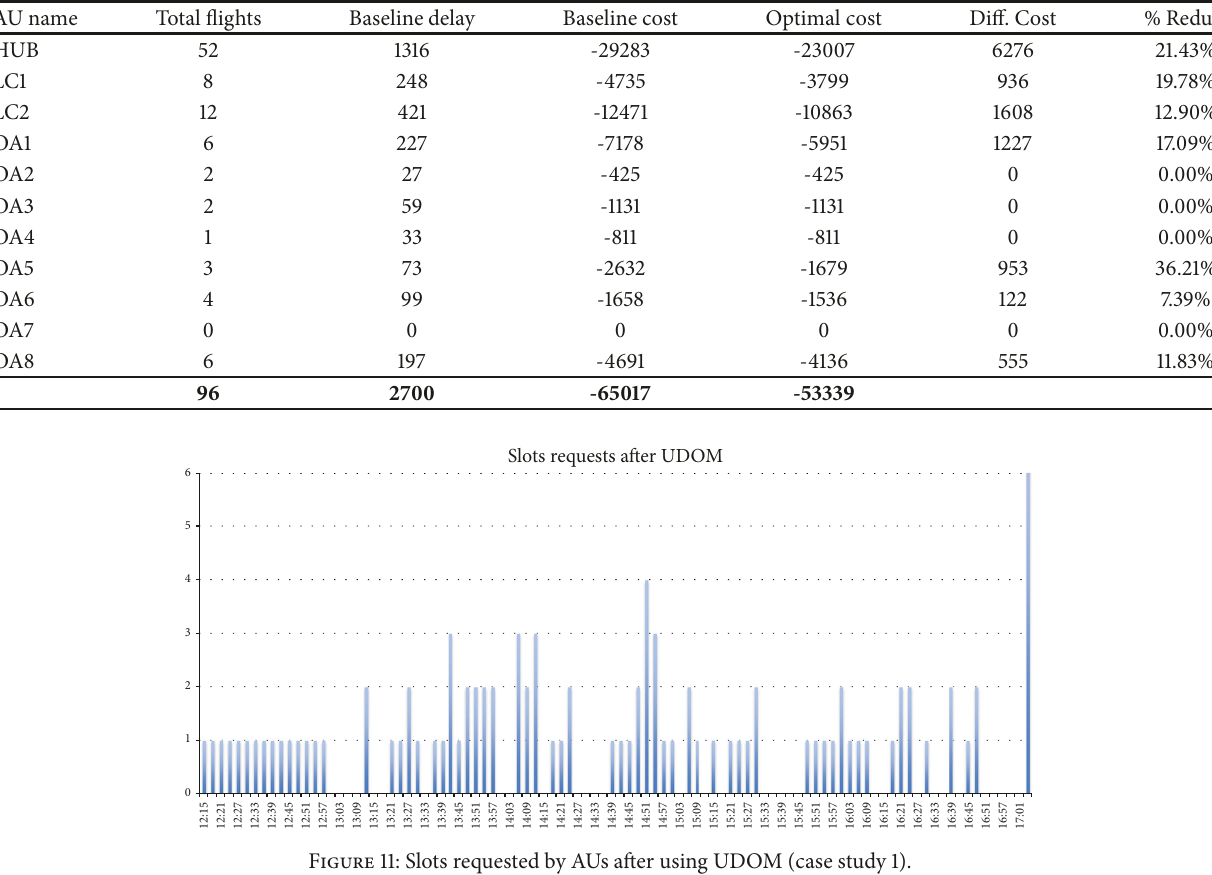
Table 3: Potential cost reductions per AU using UDOM (case study 1).